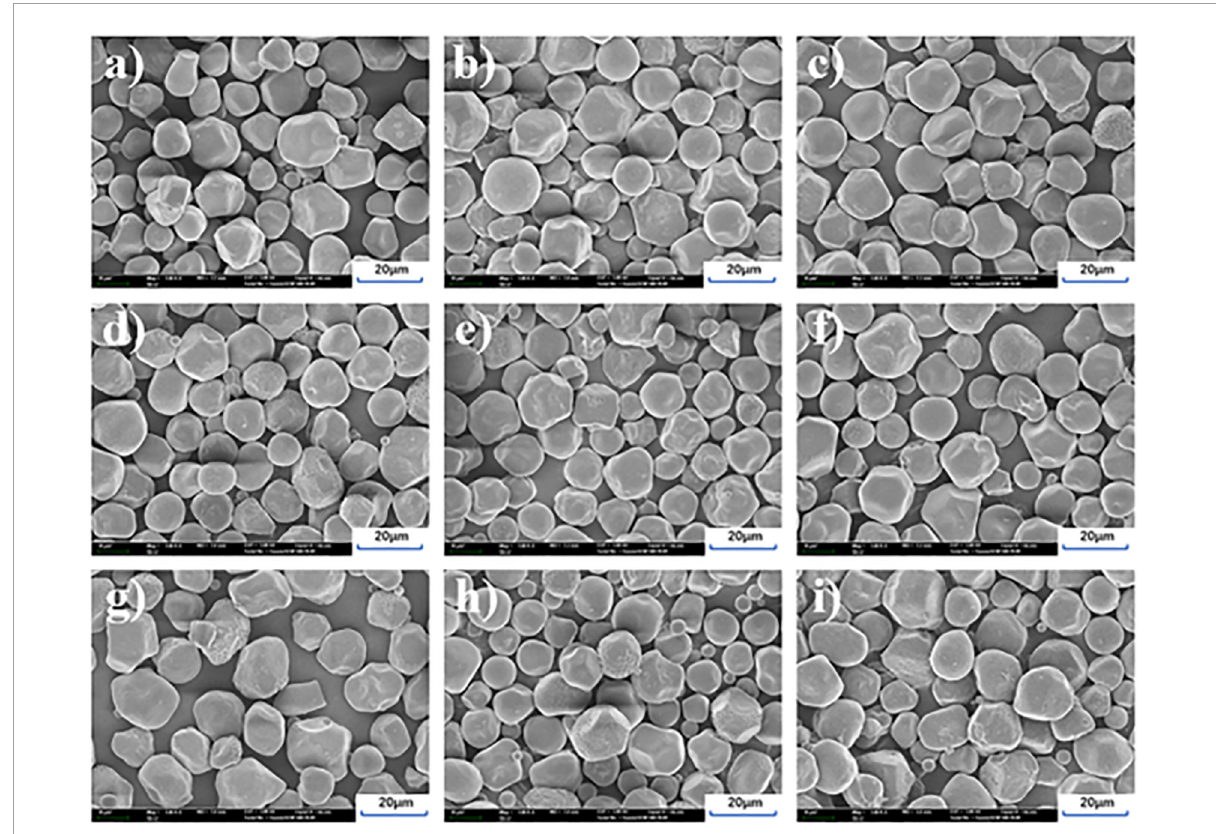
FIGURE1 SEM images of different sorghum starch varieties. (a–i) Represent the sorghum starch samples S1 to S9.